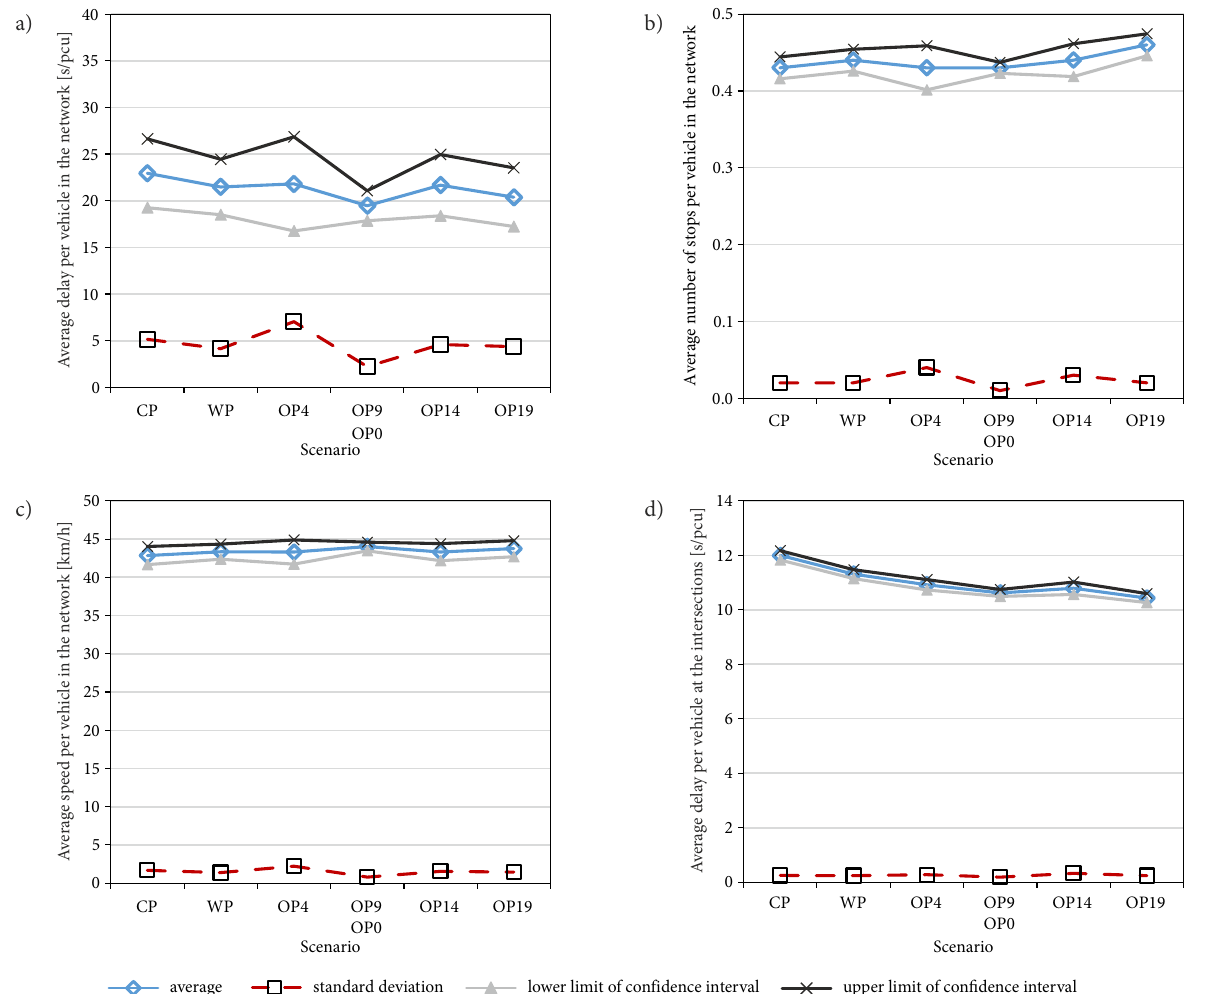
Figure 5. Comparison of the statistical indices for different scenarios: a – average delay per vehicle in the network; b – average number of stops per vehicle in the network; c – average speed per vehicle in the network; d – average delay per vehicle at the